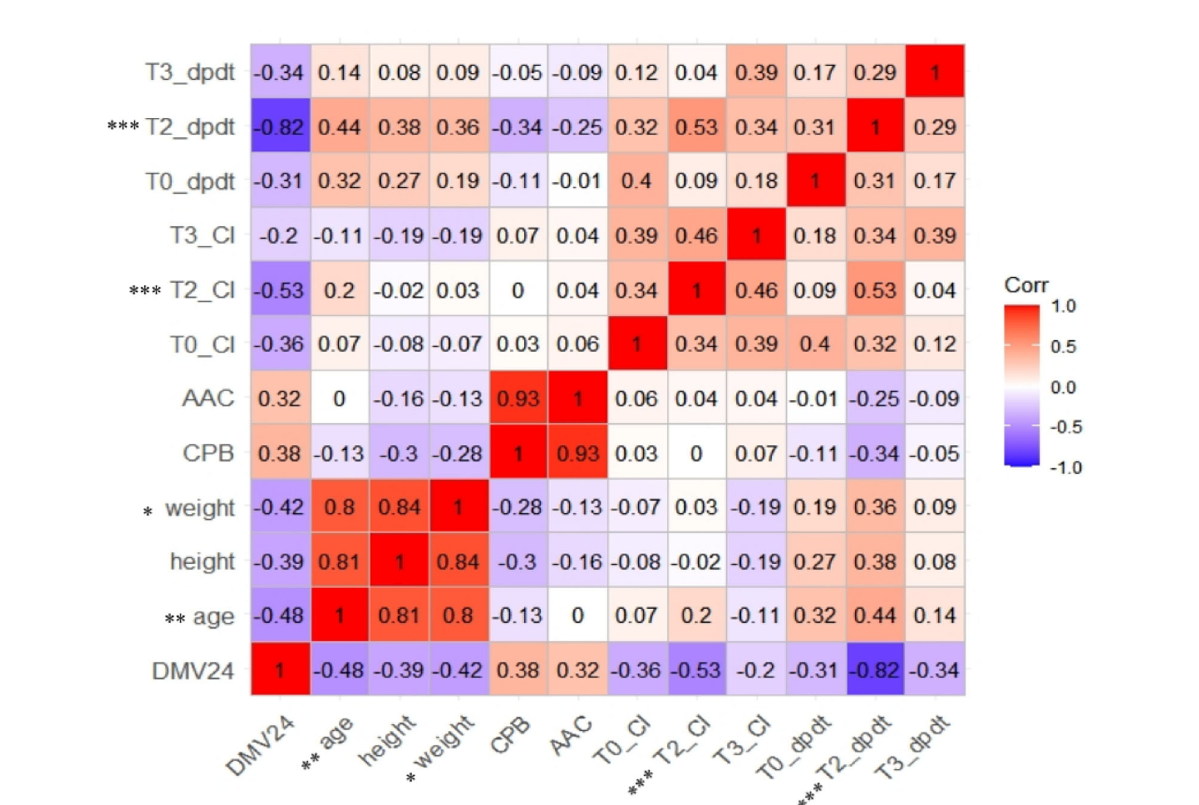
FIGURE2 Correlation analysis of heat map for relationship between selected the characteristics, hemodynamic parameters, and prolonged DMV. CI, cardiac index. Dp/dt max, the maximal slope of systolic upstroke. DMV24, binary-classified variable, duration of mechanical ventilation leq24h or >